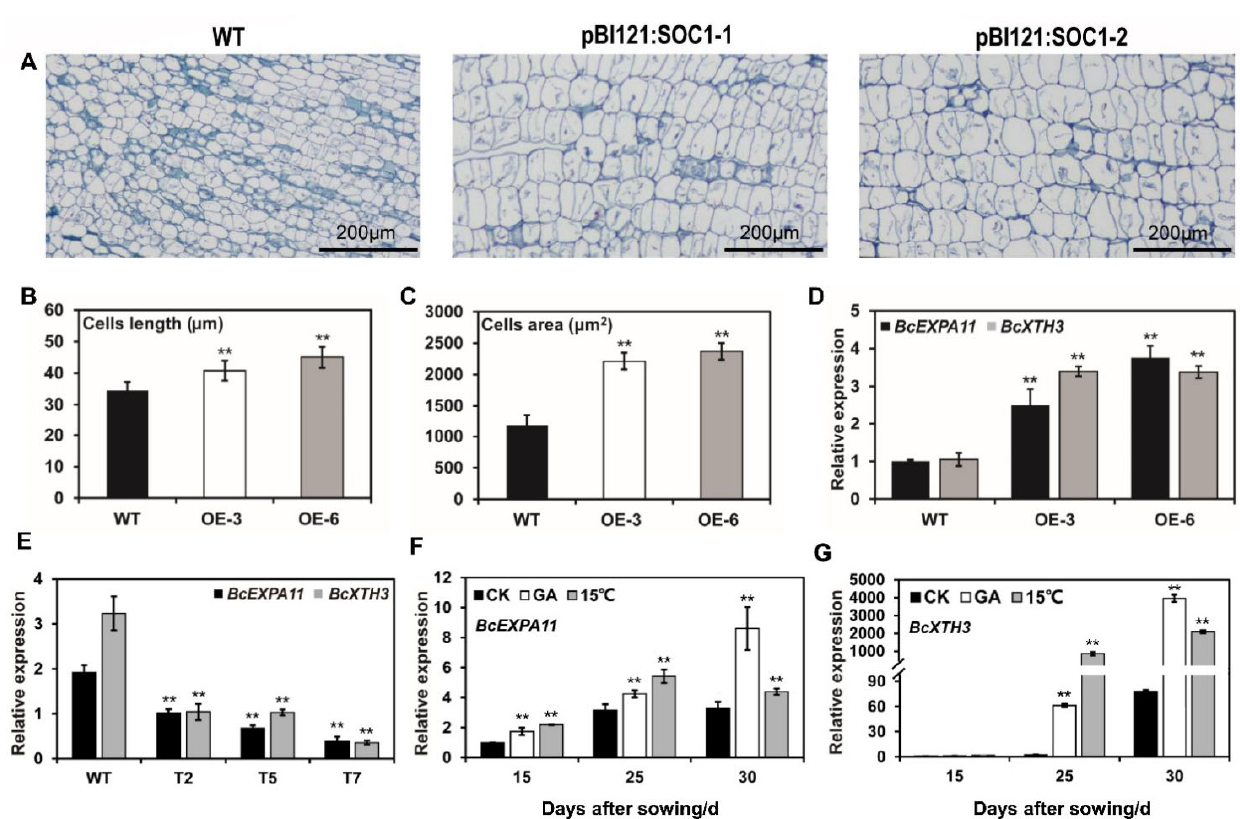
Figure 5. Expression of BcEXPA11 and BcXTH3 correlates with cell expansion. ( A ) Pith cell microstructures in the longitudinal sections of the shoot apex of wild type (WT) and BcSOC1 transgenic lines. Bar = 200 μ m. ( B , C ) Pith cell length and area in the shoot apex. ( D , E ) Relative expression of cell expansion-related genes BcEXPA11 and BcXTH3 in BcSOC1 overexpression and knockdown lines. Error bars represent standard errors. Significant differences were determined using Stu- dent’s t -test (** represents p < 0.01). ( F , G ) Expression of BcEXPA11 and BcXTH3 under GA 3 and low-temperature (15 ◦ C) treatments. CK as the control. Significant differences were determined using